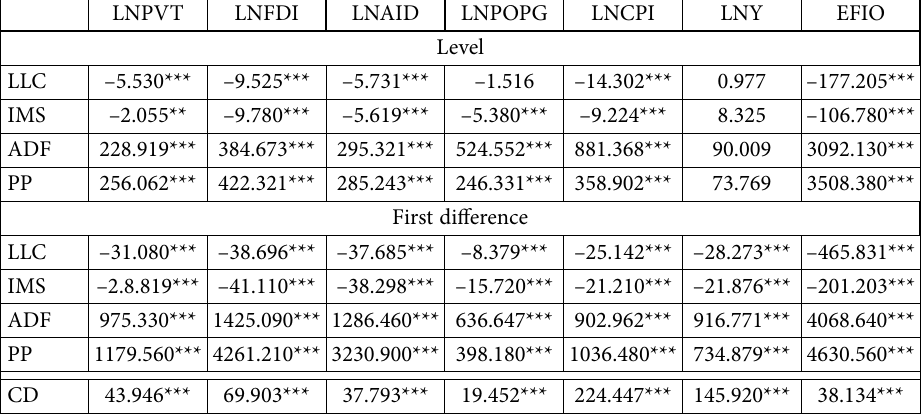
Table 4. Panel unit root tests